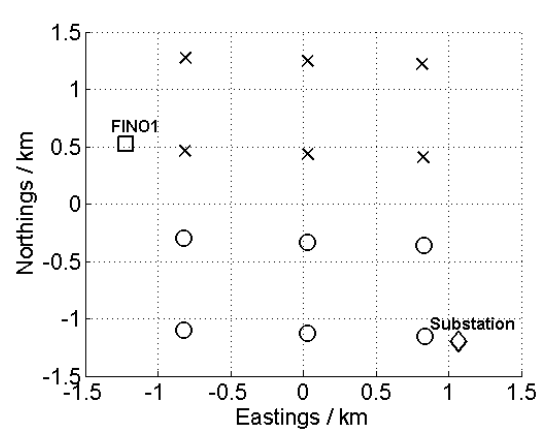
Figure 1. Layout of the offshore wind farm alpha ventus . Crosses indicate positions of Senvion 5M turbines with a diameter of 126 m (two northerly rows). Circles indicate positions of the AREVA Wind M5000 turbines with a diameter of 116 m (two southerly rows). One LiDAR was operated on the substation (◊) and two on the research platform Fino1 (□).